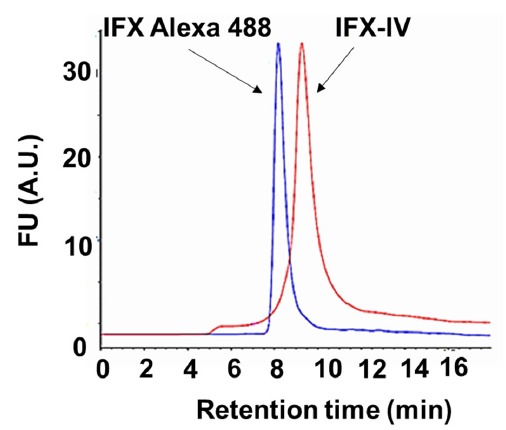
Figure 12. SE-HPLC chromatogram of compound IV-IFX conjugate (red) and IFX Alexa488 conjugate B (blue).